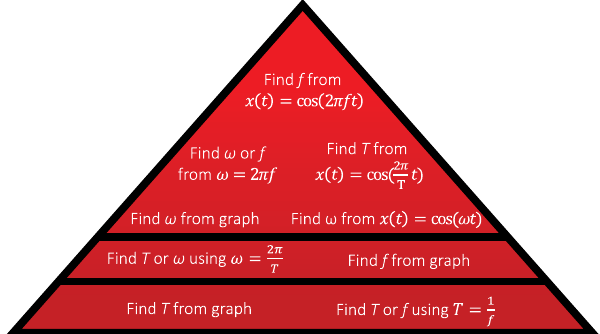
FIG. 3. A simple, informal hierarchy constructed using cross tabulations. Skills on lower levels are prerequisite to the skills on higher levels. Skills on the same level are not necessarily equivalent. Only algebra-based physics students are included in the figure.